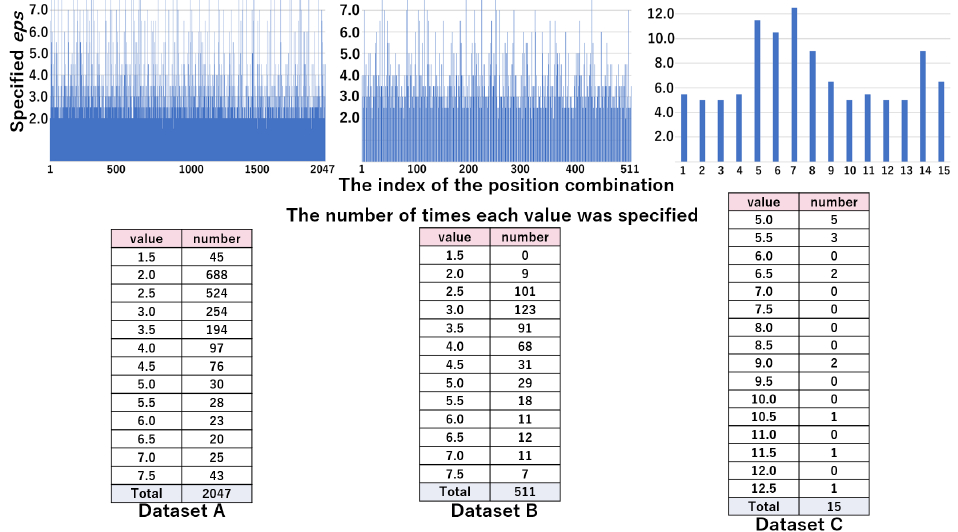
Figure 10. The values of (cid:99) eps (top figure) and their distribution (bottom table) in the WC pattern: (cid:99) eps candidates are 1.5, 2.5, 5.0, 7.5, 10.0, 12.5, and 15.0.